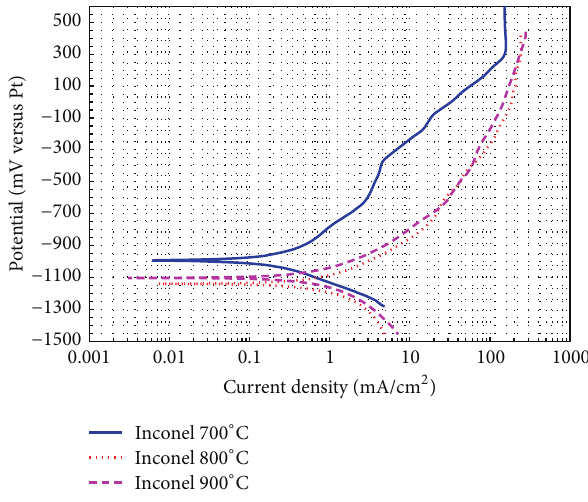
Figure 1: Polarization plots of Inconel 600 in NaCl-KCl at the different temperatures.